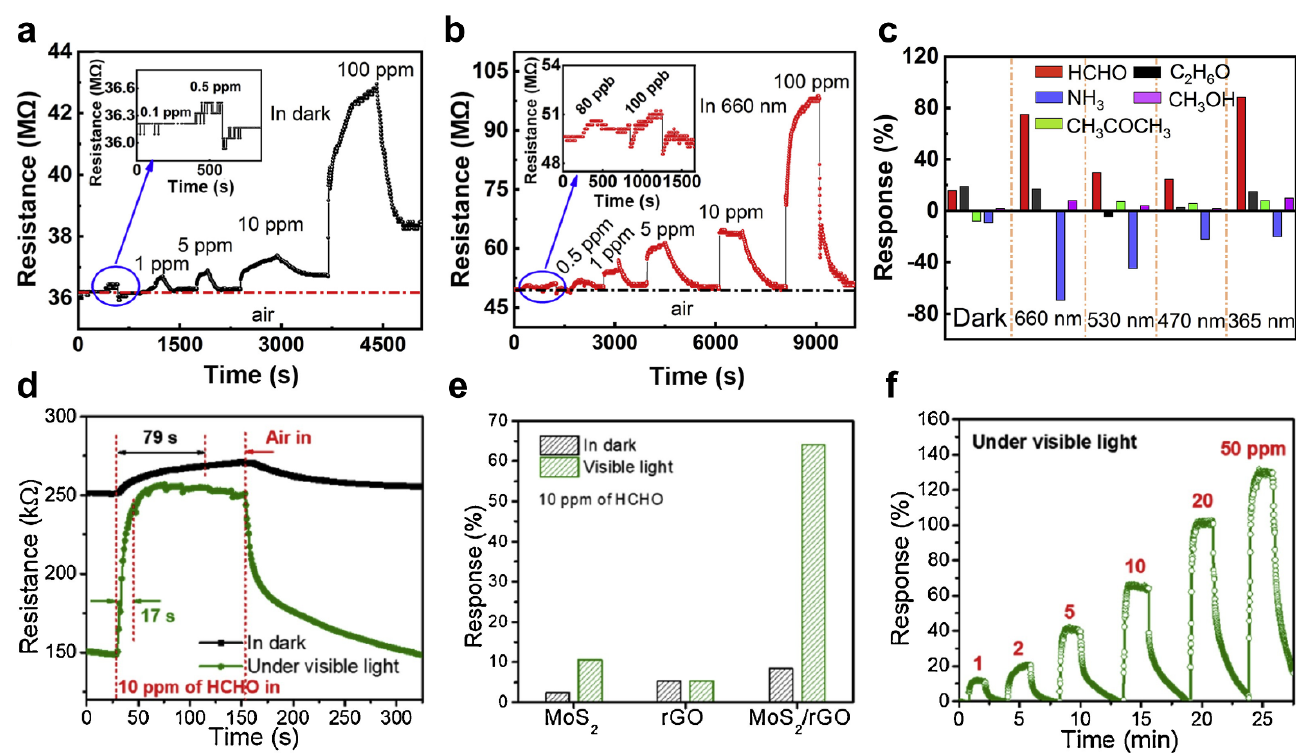
Figure 8. ( a ) Response of the HoFeO 3 gas sensor under dark and various visible light; ( b ) response of the HoFeO 3 gas sensor under red light irradiation; ( c ) selectivity characteristics of the HoFeO 3 gas sensor (adapted from [102] with permission from the Elsevier B.V.); ( d ) response of the MoS 2 /rGO hybrid gas sensor in the dark condition and visible light irradiation; ( e ) responses of pure MoS 2 , rGO, and MoS 2 /rGO hybrid gas sensors; ( f ) response of the MoS 2 /rGO hybrid gas sensor to 1–50 ppm HCHO gas (adapted from [103] with permission from the Elsevier B.V.).